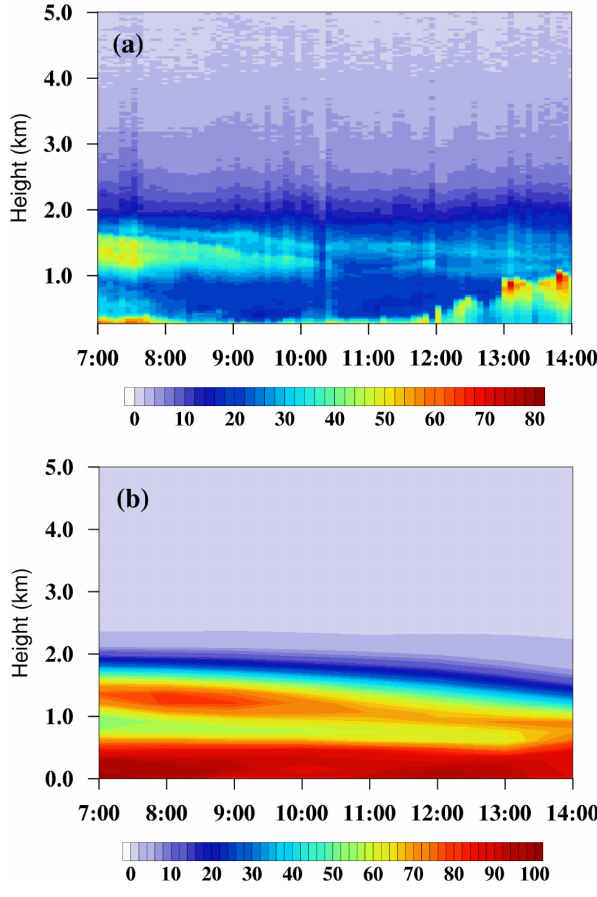
Figure 6. Vertical and time cross sections of PM 2 . 5 mass concen- trations (µgm − 3 ) from (a) MPL-4B retrieval products and (b) sim- ulation results at site 15 (Fig. 1; Table 1) on the western SCB edge during 7:00–14:00 on 5 January